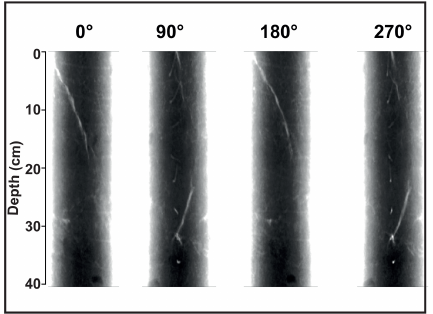
Figure 3. X-ray images of core Lomvi 893MC. The different rota- tional planes show a whitish X-ray transparency extending through- out the core. This zone is interpreted as a zone of weakness facili- tating fluid and gas migration in situ. The void probably became gas filled after core recovery. A rotational video of this core is available in the